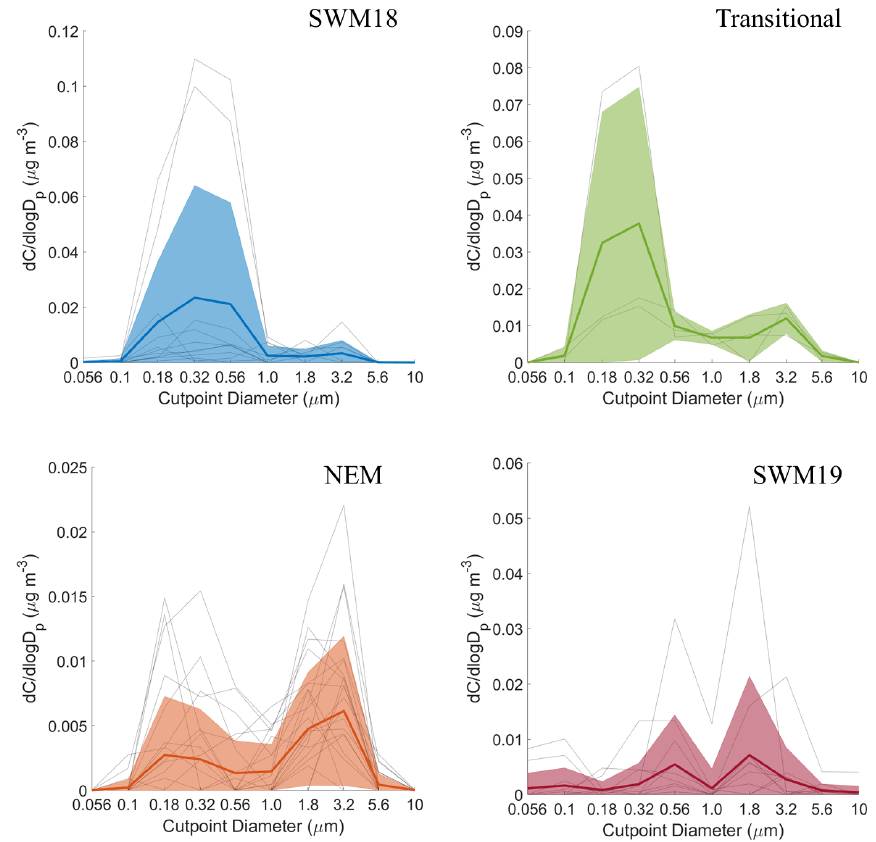
Figure 6. Seasonal size distributions of phthalate. Gray lines represent individual sets, dark colored lines are the average of all seasonal distributions, and transparent colored areas represent 1 standard deviation. Note that the range of concentrations presented on the y axis varies for each